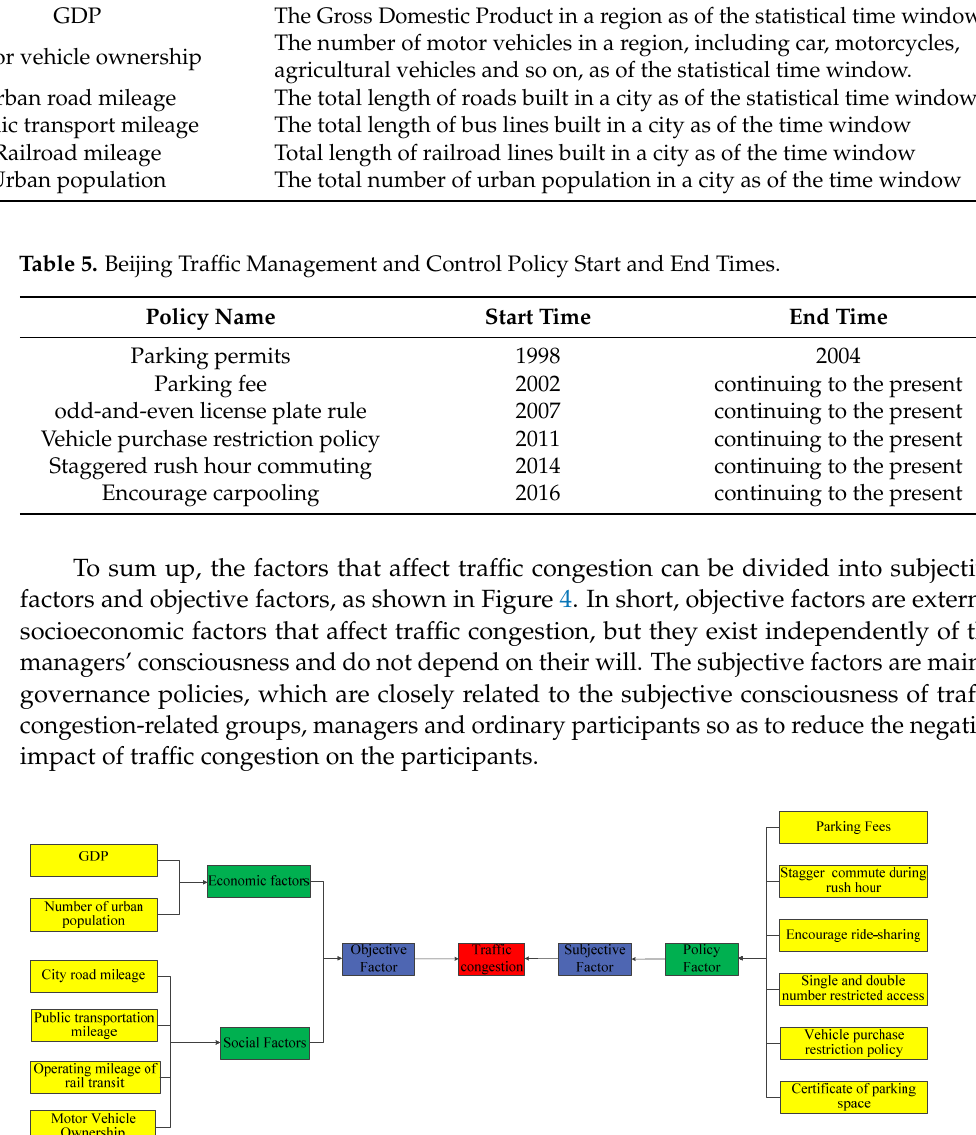
Figure 5. The numerical volatility of influencing factors. According to the curve trend in Figure 5, GDP, the number of motor vehicles, resi- dent population and railway mileage are all on the increase. Among them, the GDP in- creased nearly nine times, from 316.17 billion yuan in 2000 to 303.20 billion yuan in 2018. The number of motor vehicles increased from 1.5 million in 2000 to more than 6 million in 2018, with an average annual increase of nearly 300,000. As for the population, it is only 13.56 million at the beginning. By the end of the statistical period, this figure is al- most twice the original. For the other three second-order factors, the growth trend is different, although the number is also rising in the statistical period. For example, as far as bus mileage is concerned, by 2006, their lengths increased by about 6000 km, but then it decreased, and there are some fluctuations with time. Similarly, urban road mileage, regarding 2008 as the time cut-off point, grew rapidly before 2008, by nearly 4000 km in eight years. However, since then, the growth has been slow, with a downward trend in individual periods.